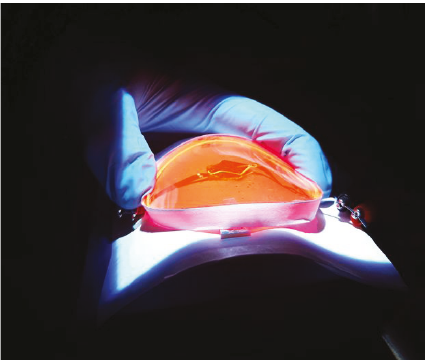
Figure 3: Electrical characterization of a bulk-doped LSC device pressed over a 5cm bend tool. The LSC is placed above and inside of the 83% re fl ective paper. Due to the rigid solar cell placed in the device center, only regions outside the 1 cm × 1cm square were allowed to bend.